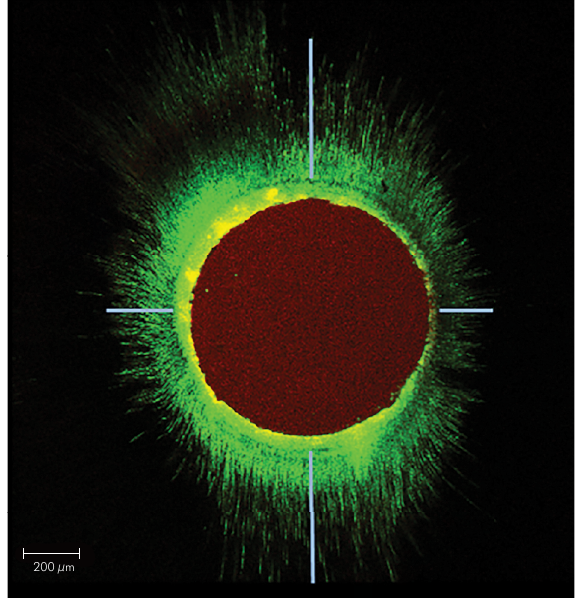
Figure 1. All teeth had their image recorded in the confocal laser scanning microscope with four standardized points (line blue) for linear gauging.